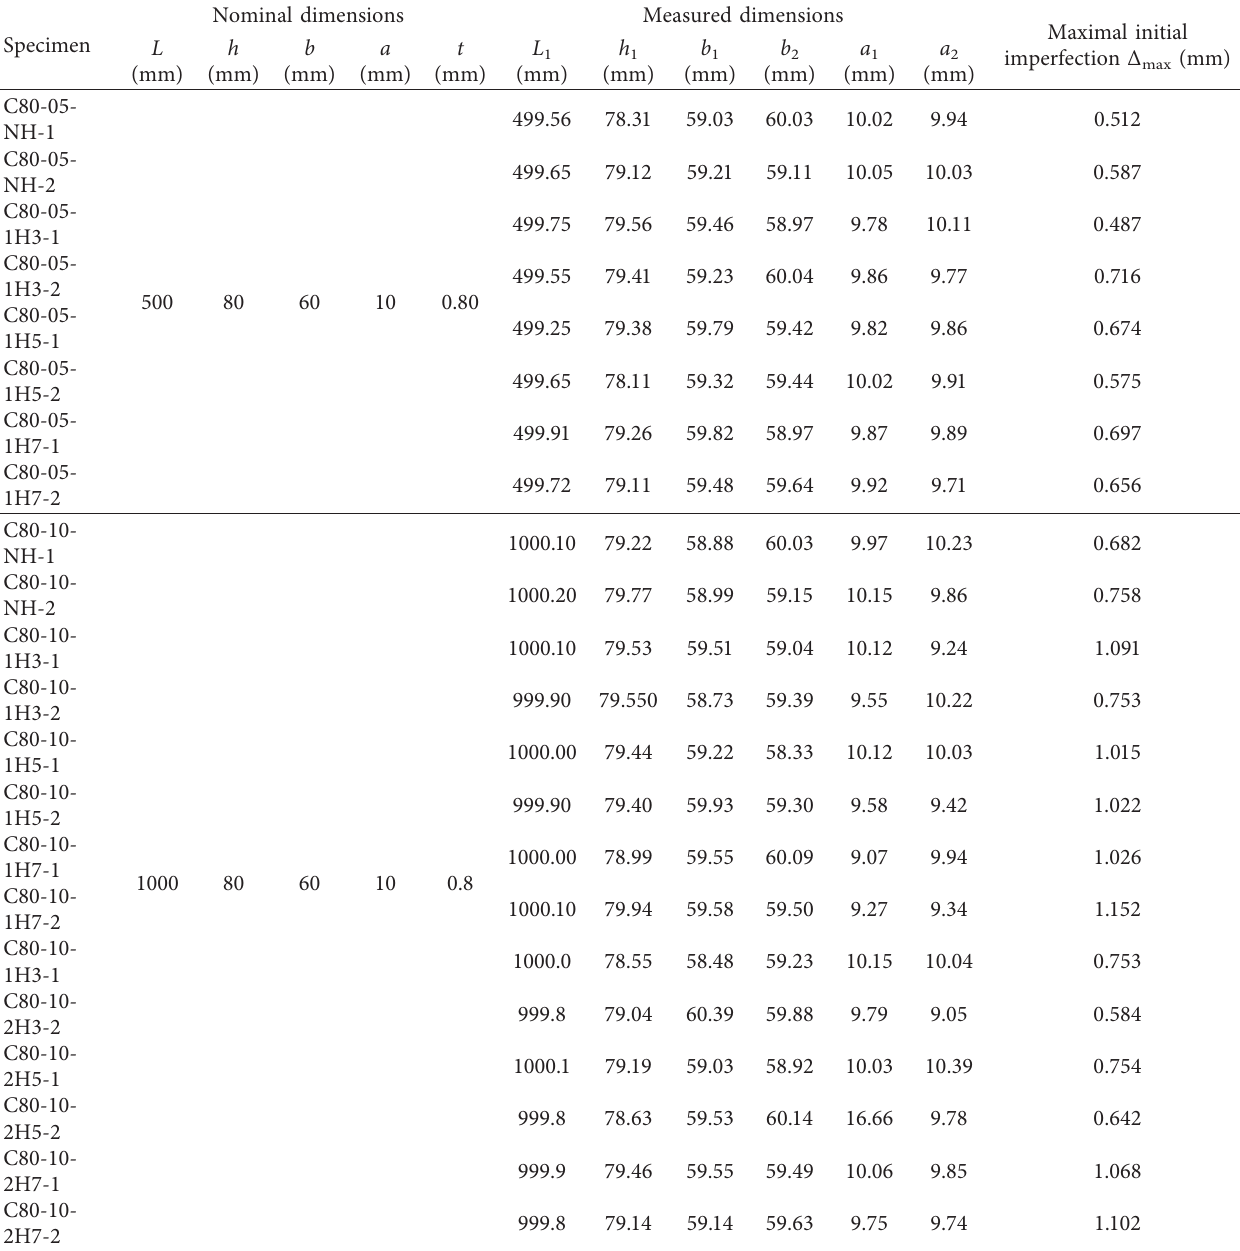
Table 1: Nominal and measured dimensions of